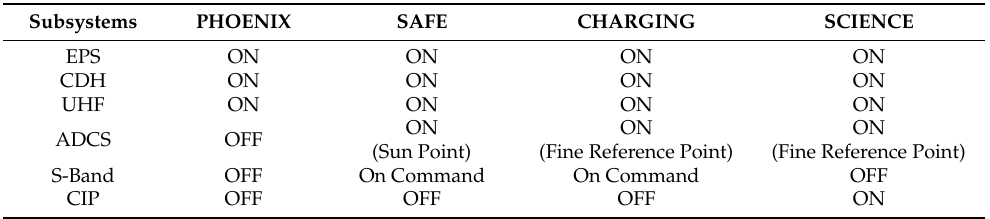
Table 7. Subsystem status in all operating modes. ADCS operating mode denoted in parentheses. “On Command” refers to activation by command uplinked from ground